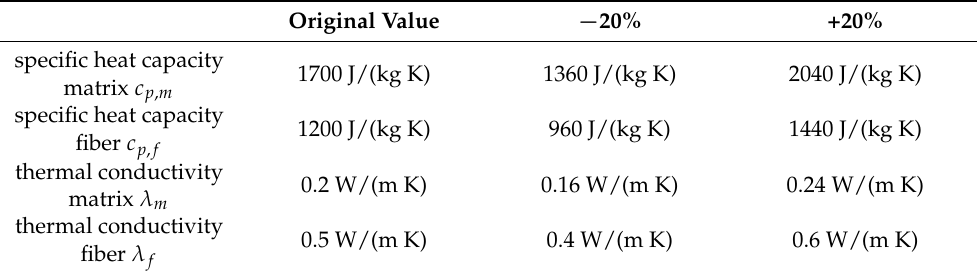
Table 2. Material parameters for the sensitivity